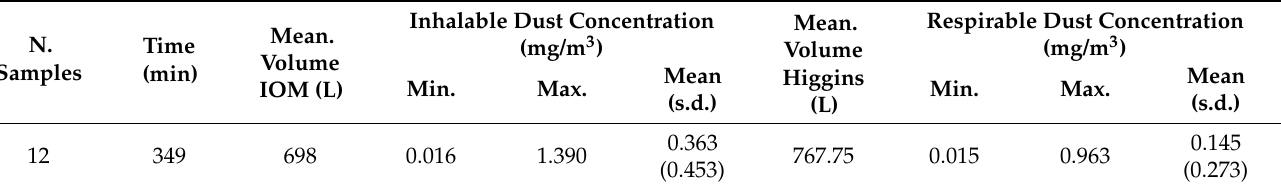
Table 5. Inhalable and respirable dust sampled with IOM and Higgins cyclones